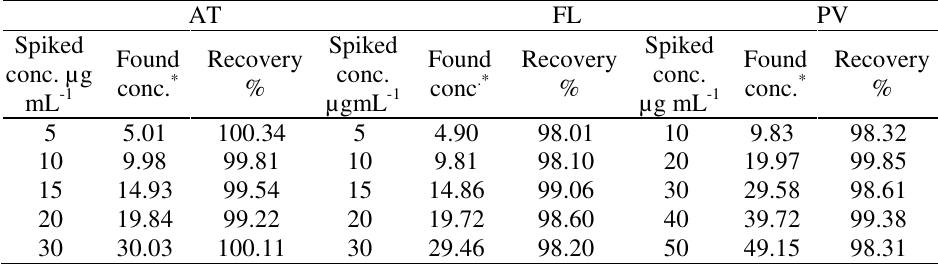
Table 3. Determination of atorvastatin, fluvastatin and pravastatin in spiked human plasma